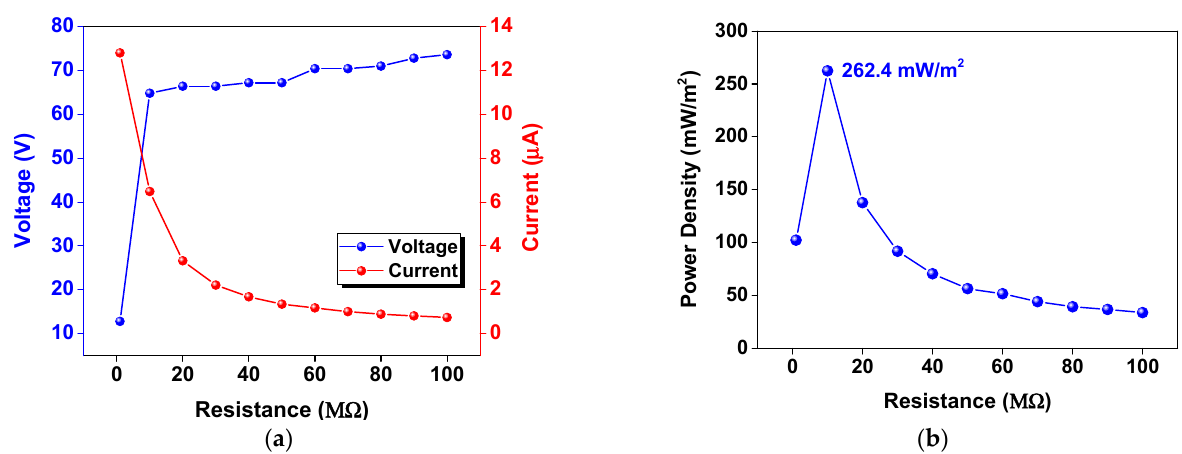
Figure 8. ( a ) Voltage and ( b ) current outputs of the NR@AgNPs (1.5 mM CTAB) TENG at various operation frequencies ranging from 2 to 9 Hz.